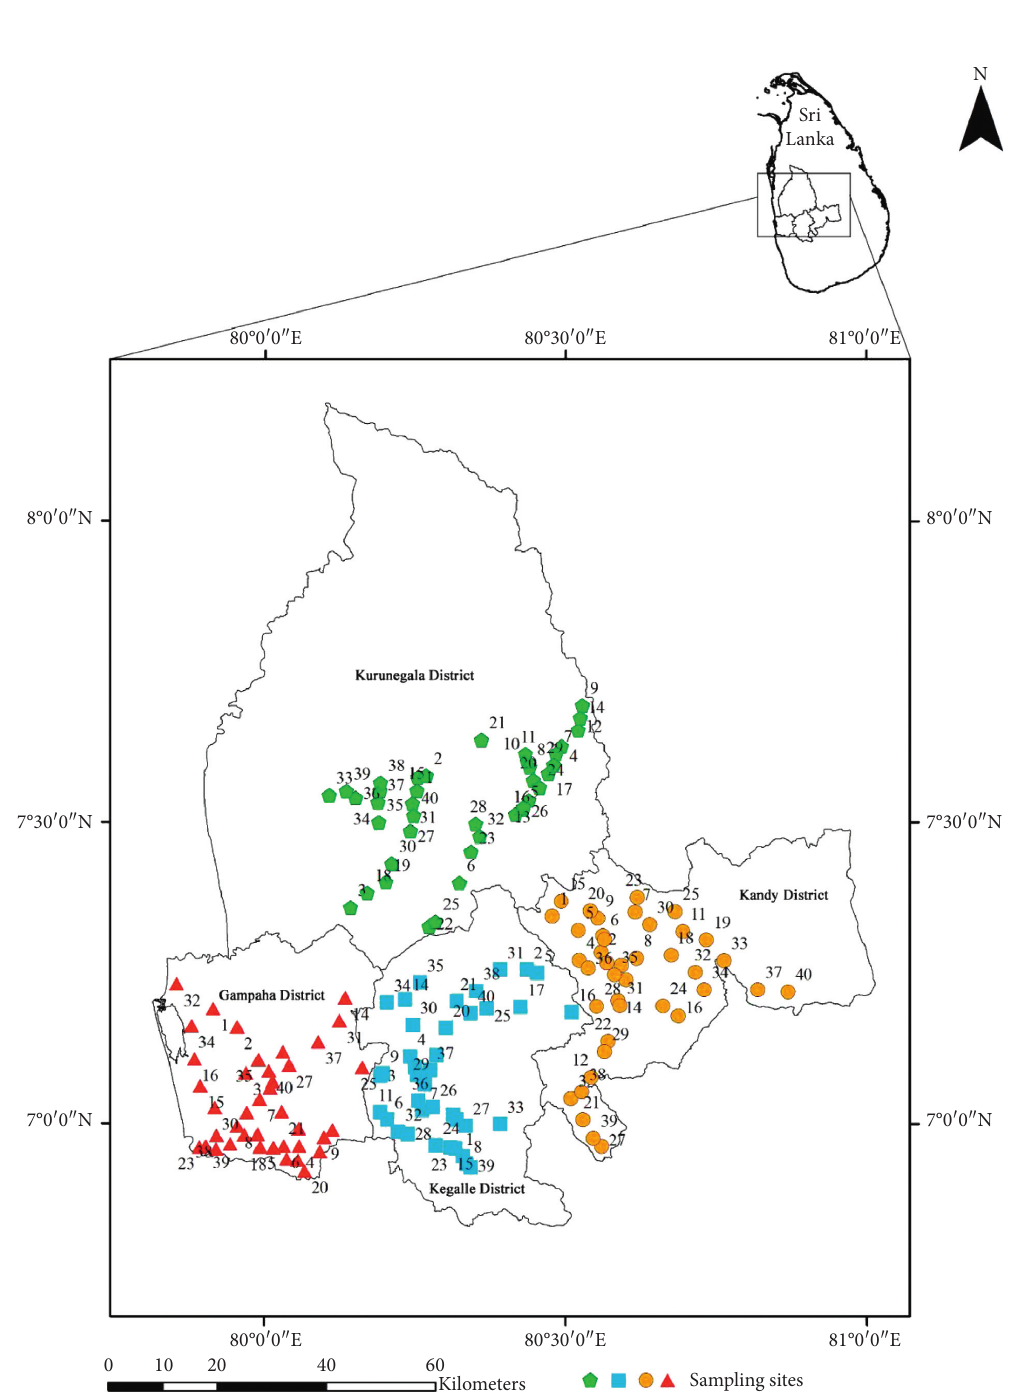
Figure 1: Sampling locations from the selected four district study sites: Kurunegala, Gampaha, Kegalle, and Kandy, Sri Lanka.